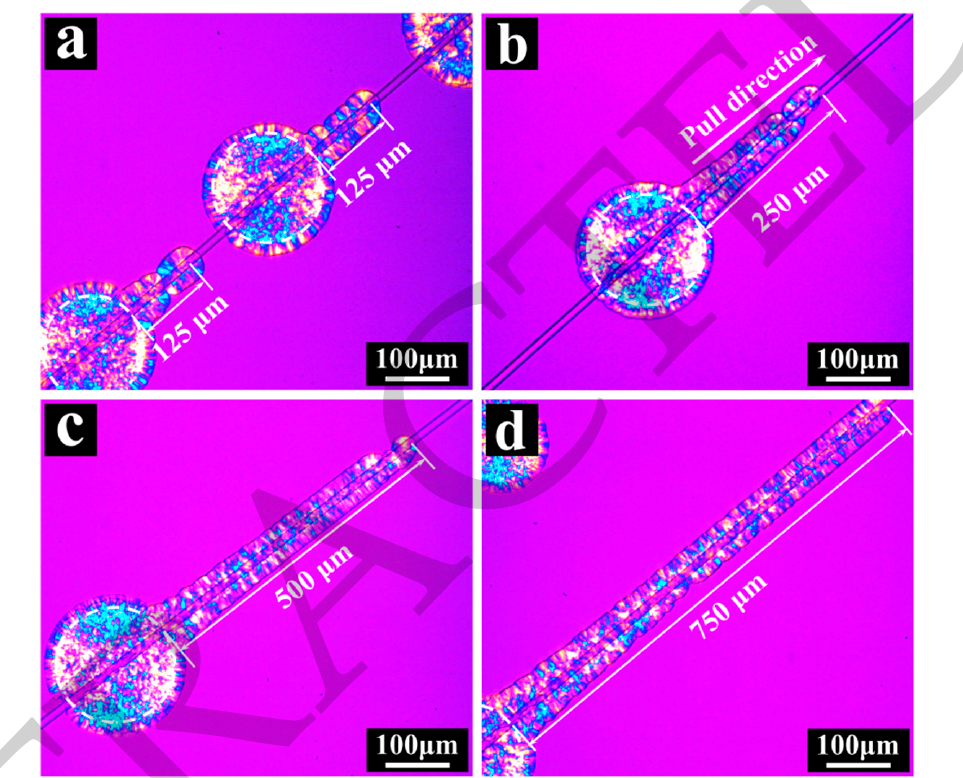
Figure 4. The selected optical micrographs obtained at t c2 = 15 min and T c = 135 °C after fiber pulling with different pulling distances. ( a ) 125 μ m, ( b ) 250 μ m, ( c ) 500 μ m, ( d ) 750 μ m. The fiber-pulling rate was 12.5 μ m /s.